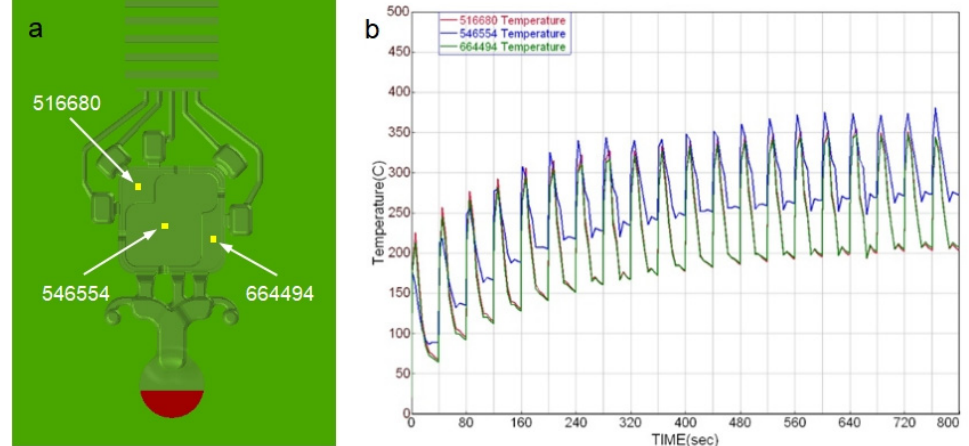
Figure 4. Simulation results of die surface temperature during preheating cycles: ( a ) selected points on die surface and ( b ) simulation results of temperature curves of selected points.